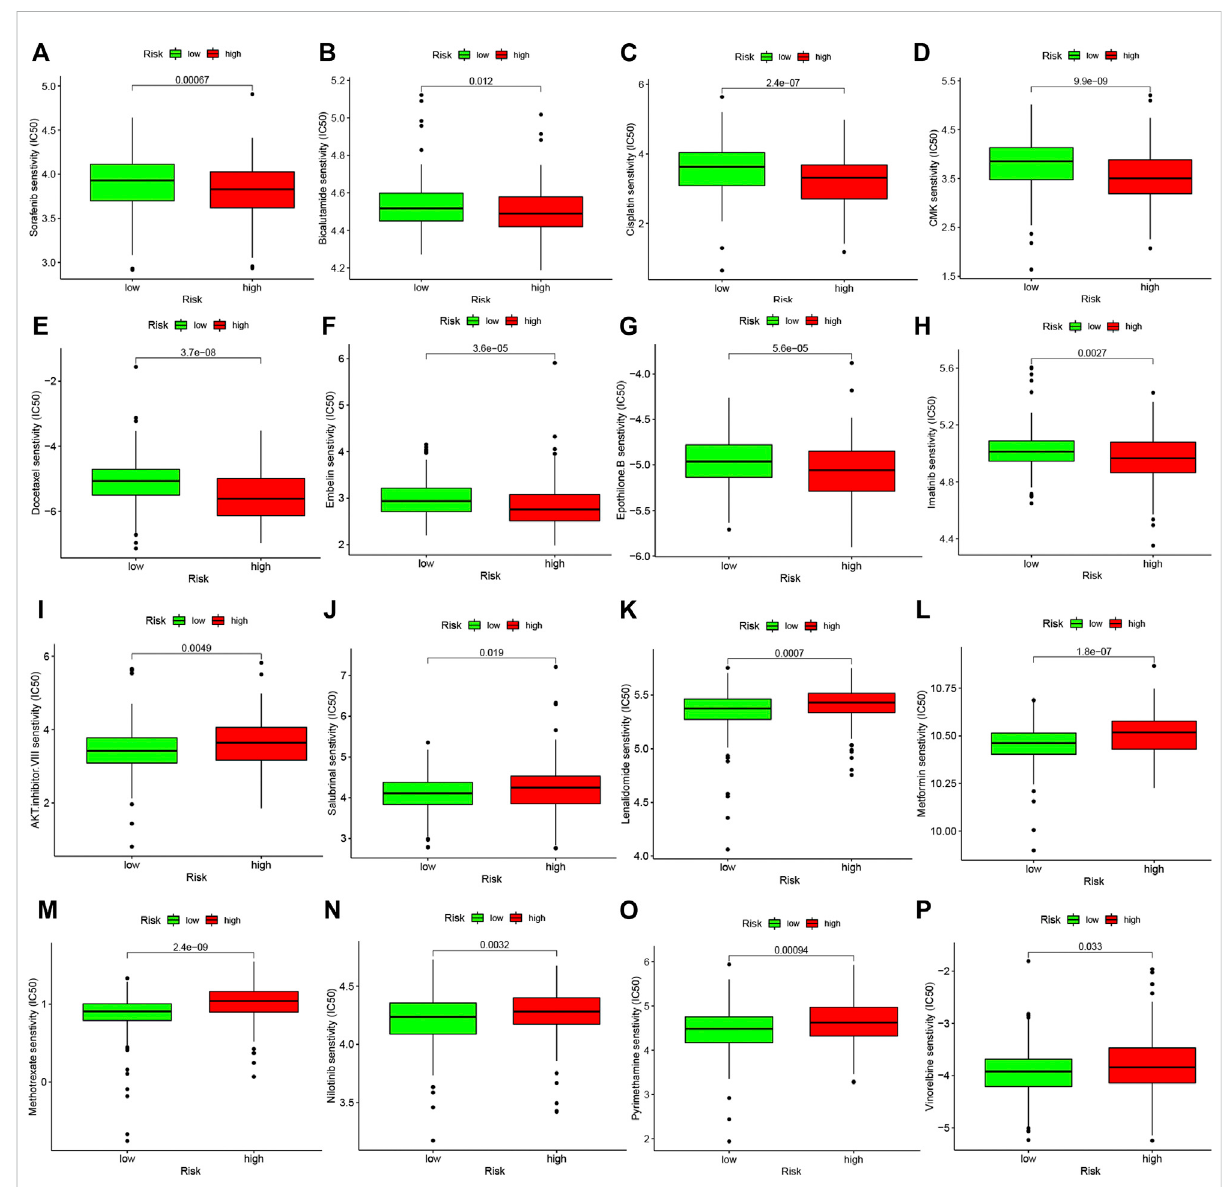
FIGURE 10 Difference analysis ofanti-tumor drugsensitivitybetweenhighand lowriskgroups. (A – H) :The low-risk groupwasmoresensitive toSorafenib, Bicalutamide, Cisplatin, etc. (I – P) : The high-risk group was more sensitive to Camptothecin, Lenalidomide, Methotrexate,